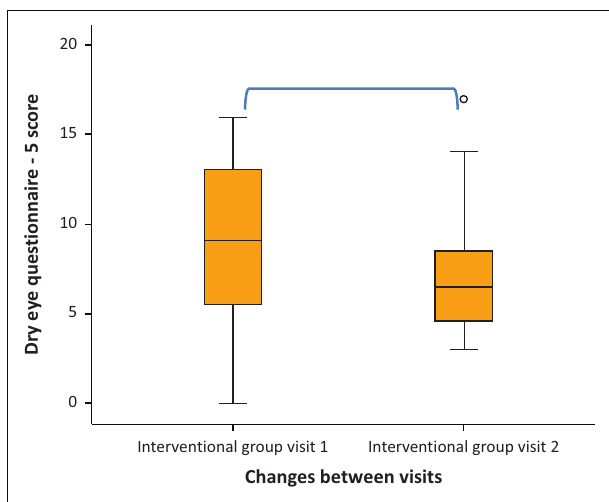
FIGURE 3: Box plots for Dry Eye questionnaire 5 score for the intervention group. Significant changes between visits.